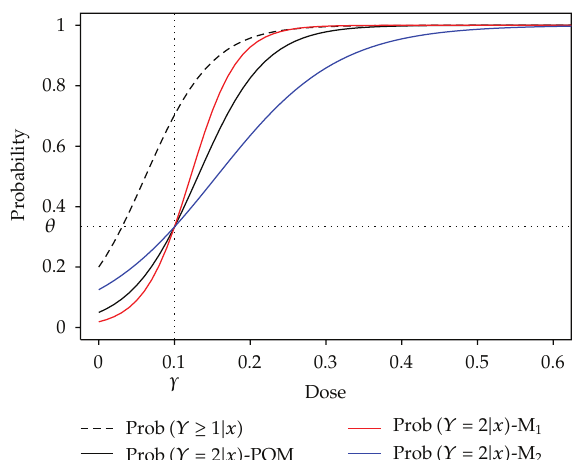
Figure 6: Dose-toxicity relationship under the proportional (cid:2) EWOC-POM (cid:3) and nonproportional odds models (cid:2) M 1 and M 2 (cid:3) when the true MTD γ (cid:7) 0 . 1. The dashed horizontal line corresponds to the target probability of DLT θ (cid:7) 0 .